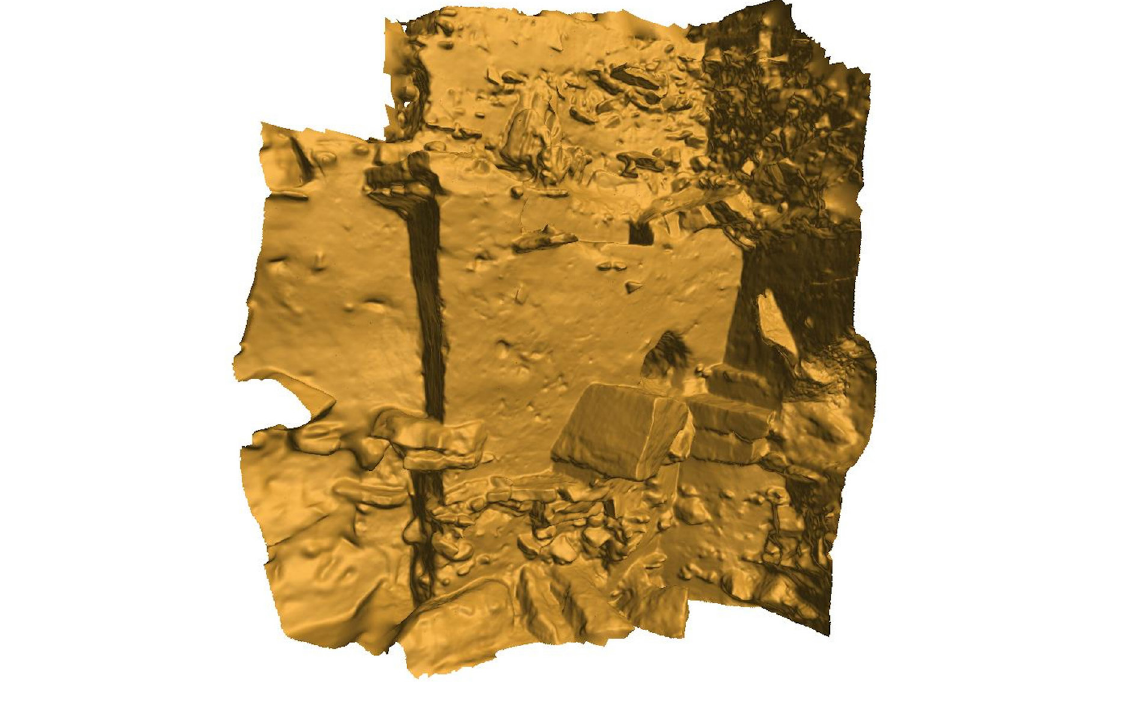
Fig. 3.33. Scan of a part of the excavation at Scladina cave (Belgium) made with the Gotcha. The part of the site pictured measures approximately 2×2